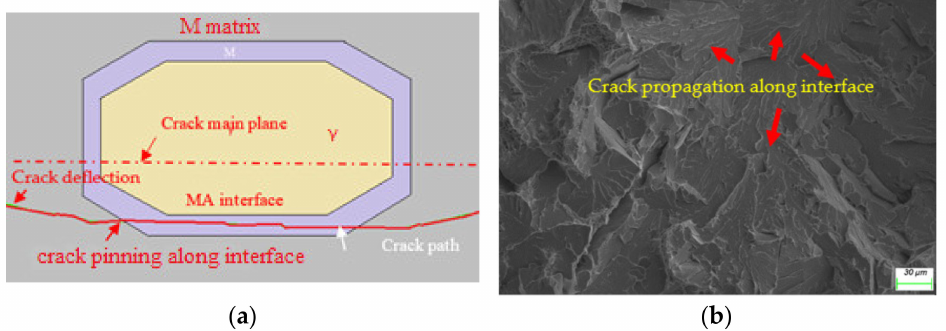
Figure 10. Brittle morphology induced by blocky MA: ( a ) numerical simulation; and ( b ) its experi- mental counterparts.